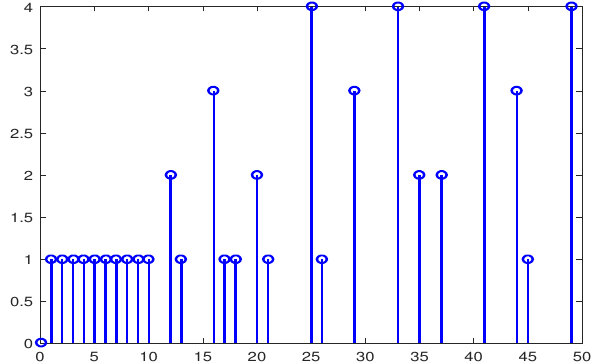
Figure 6. The event-triggering release instants and release intervals.